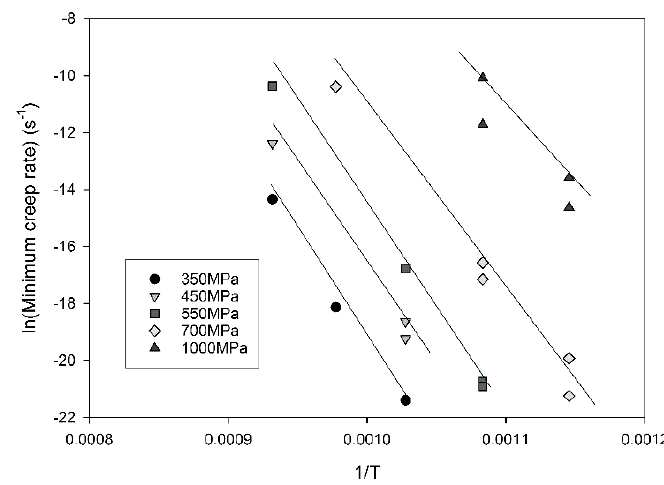
. ε m vs. 1/Temperature in Waspaloy. Figure 5. The relationship between ln ε(cid:4662) m vs. 1/Temperature in Waspaloy.